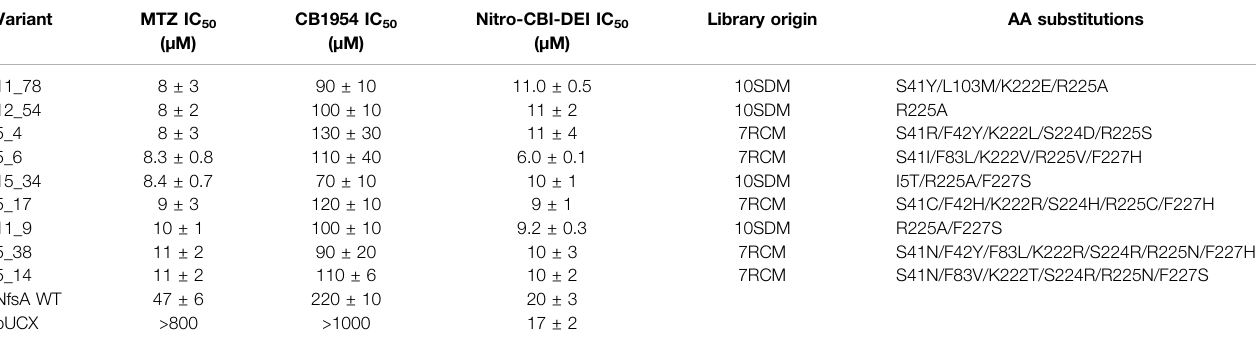
TABLE1| IC 50 valuesfor Escherichiacoli cellsexpressingthenineselectedNfsAvariants,wildtypeNfsA(NfsAWT),orpUCXcontrol,followingchallengewithmetronidazole (MTZ), CB1954 or nitro-CBI-DEI.